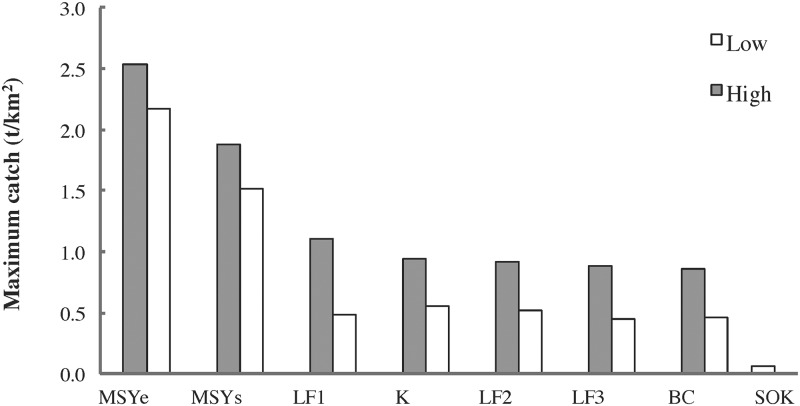
Maximum herring catches by EwE MSE scenario.High and low: Blim for MSY, Ftarget otherwise.